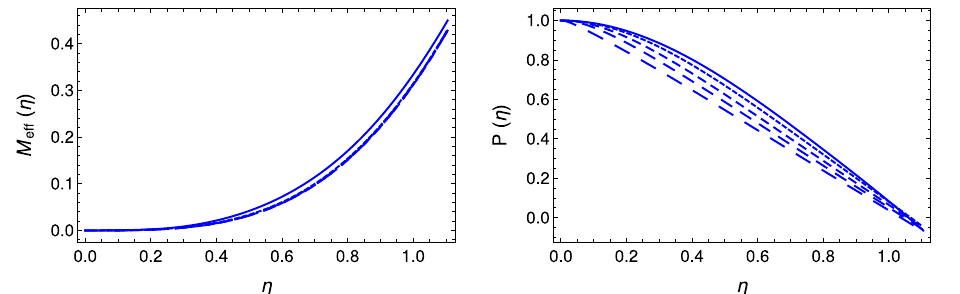
Fig. 1 Variation of the effective mass M eff (left figure) and of the dimensionless pressure P (right figure) as a function of the dimension- lessradialcoordinate η forastarwithspindensity S 2 ∝ p 2 ,fordifferent